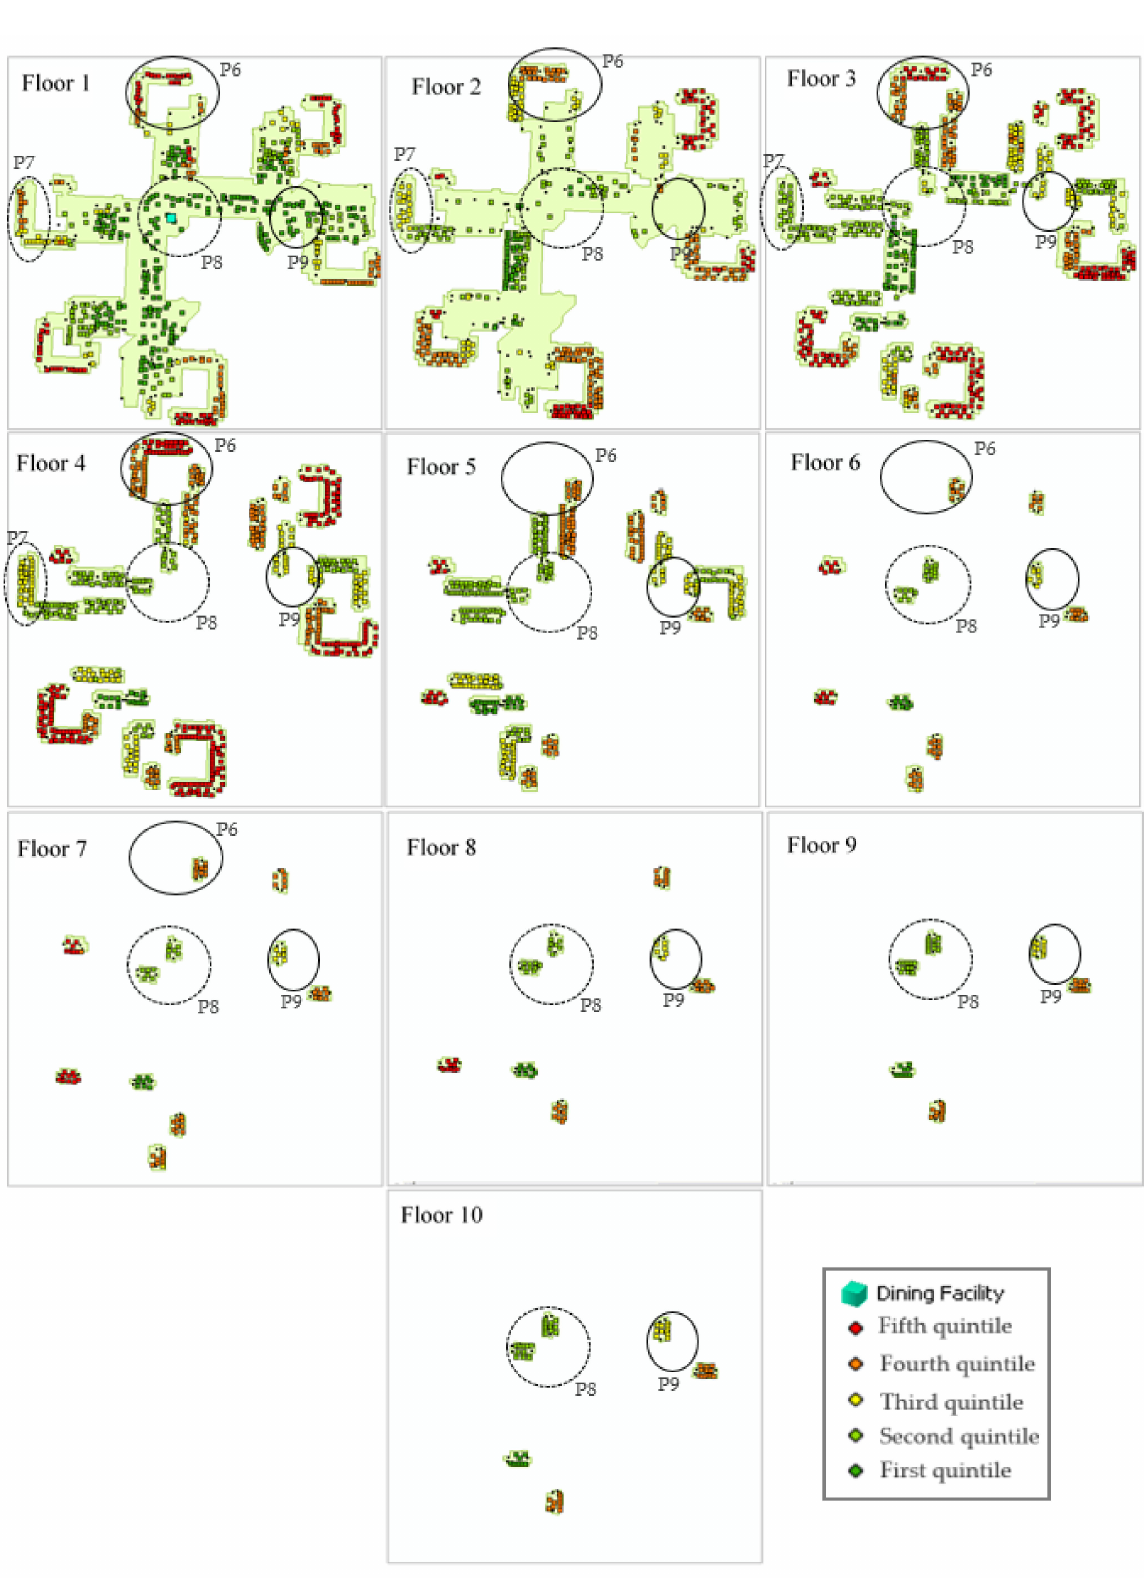
Figure 21. Syntactic accessibility to dining facility 3 on different floors: classification in quintiles. The syntactic approach, however, does not consider the metric component (i.e., dis- tance or travel time) of the vertical turns but rather its syntactic and cognitive component. Syntactically and cognitively, the impedance of every vertical turn equals 1,